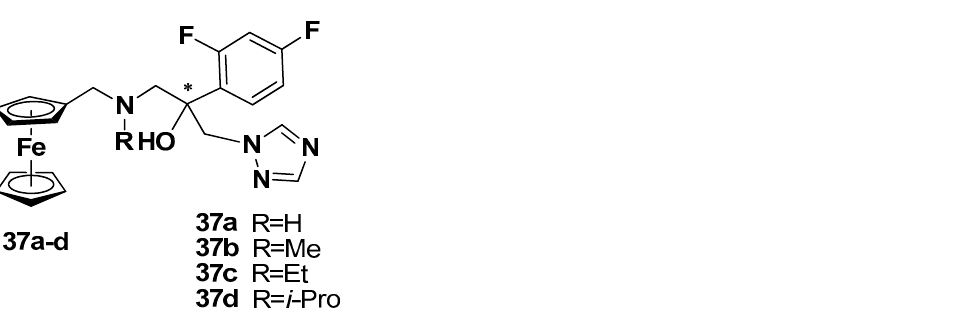
Figure 18. Ferrocene-modified fluconazoles; an asterisk in structures means a stereogenic center.